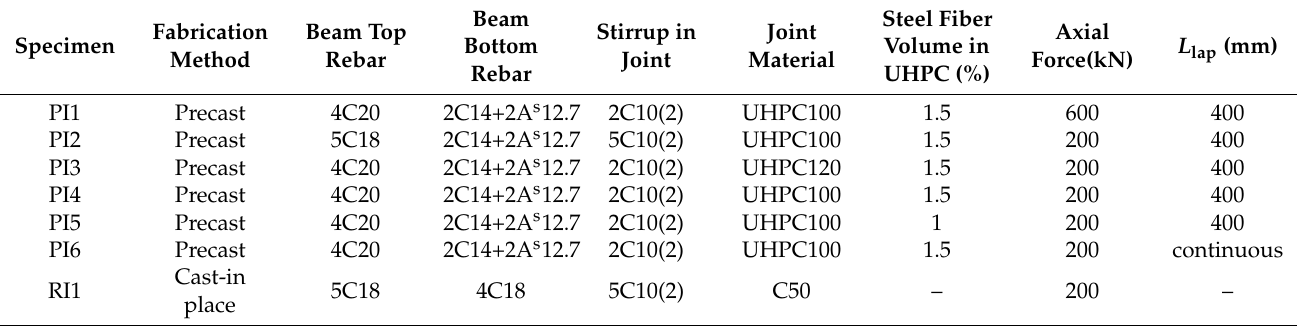
Table 1. Key parameters of the specimens.